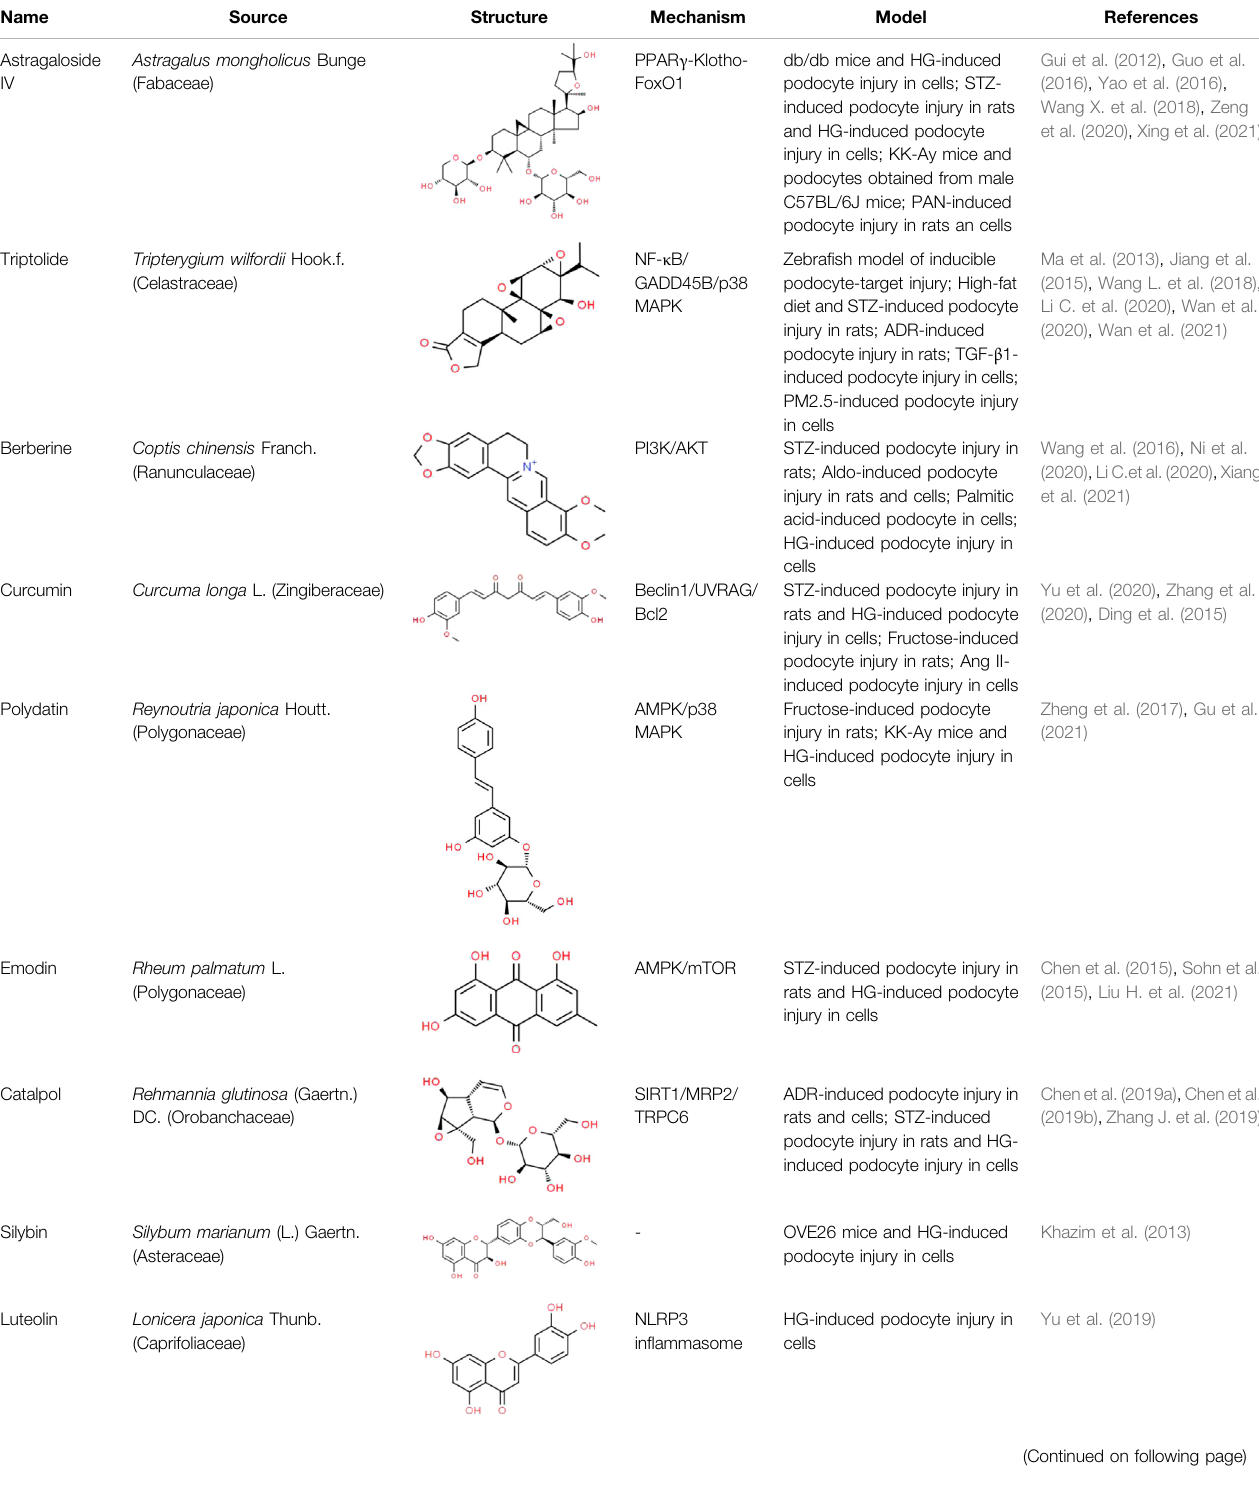
TABLE 1 | Active ingredients of TCM potential therapeutic effects on podocyte